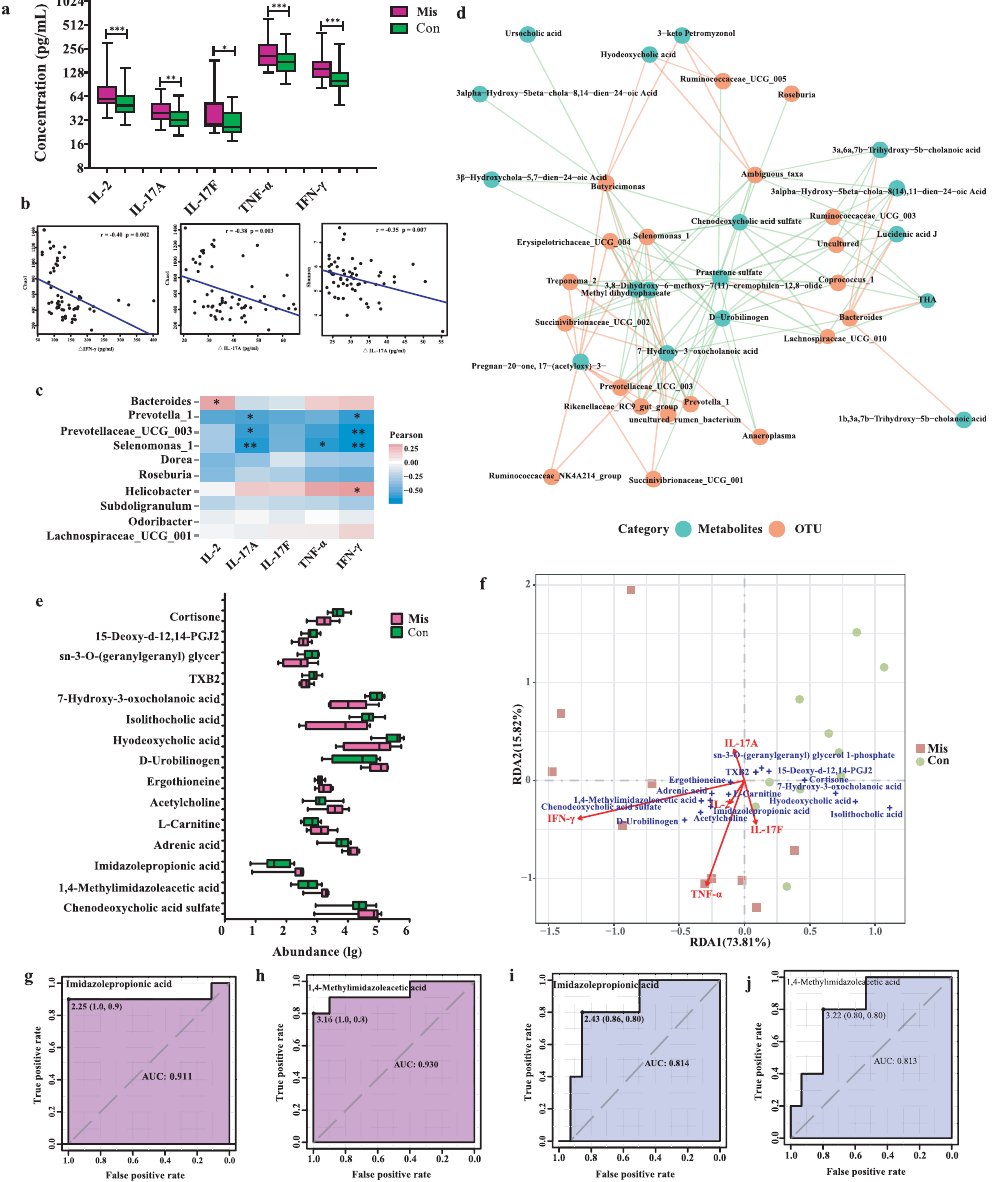
Correlation between Chao1 index, Shannon index, and proin fl ammatory cytokines using Pearson ’ s linear correlation model. c Heatmap analysis of the correlation between the top 10 abnormal genera and proin fl ammatory cytokines. Orange represents positive correlations and blue negative correlations. * p < 0.05, ** p < 0.01. d Network analysis of the correlation between abnormal genera and discriminatory metabolites. Red line represents positive correlations and green negative correlations. e Abundance pro fi les analysis of the microbe-associat e d metabolites. Data are shown as mean ± SD. Abundance (lg) means the abundance with log10 transformation. f RDA analysis of the correlation between in fl ammatory cytokines and discriminatory metabolites. g-j ROC analyses for metabolite abundance showing the high AUCs